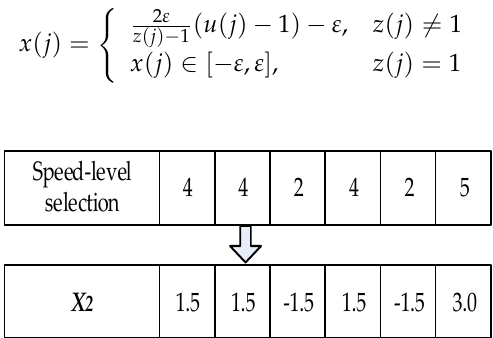
Figure 7. The conversion process from speed-level selection to individual position vector.